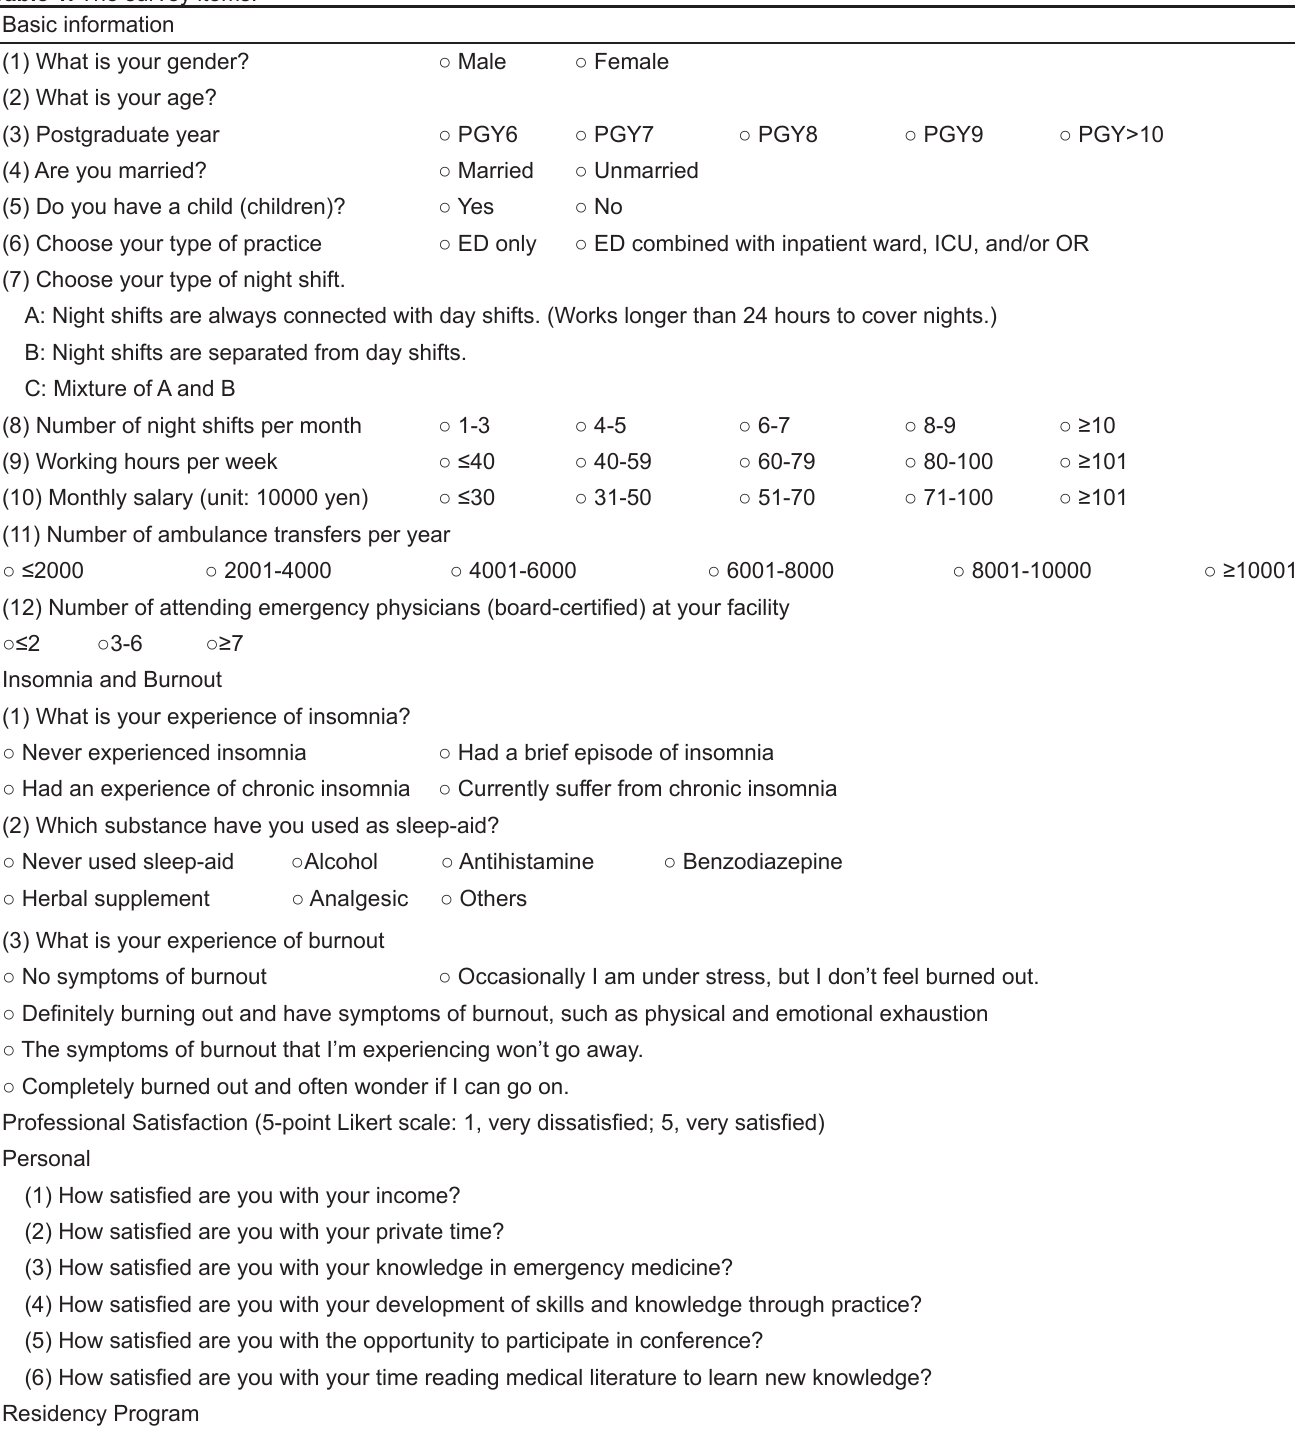
Table 1. The survey